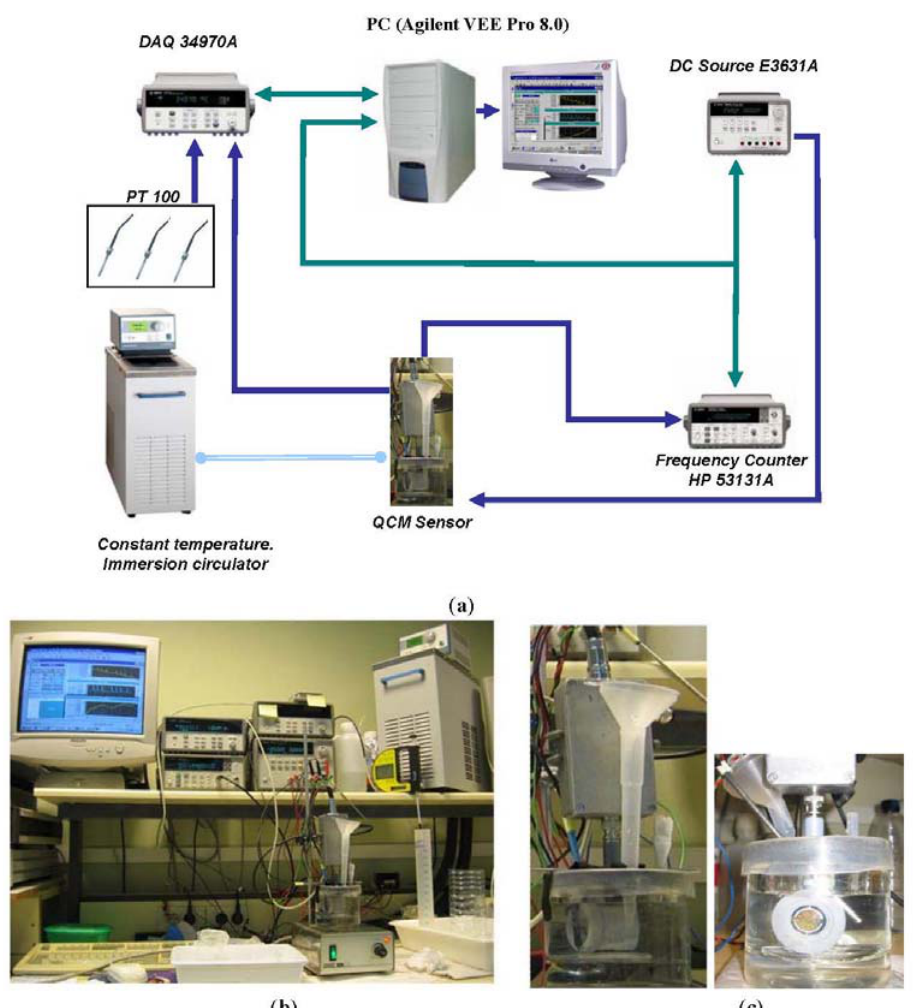
Figure 2. Experimental setup for the calibration of the sensor ( a ) Connection diagram, ( b ) Experimental test bench, ( c ) Quartz Crystal during the calibration with solutions of sulphuric